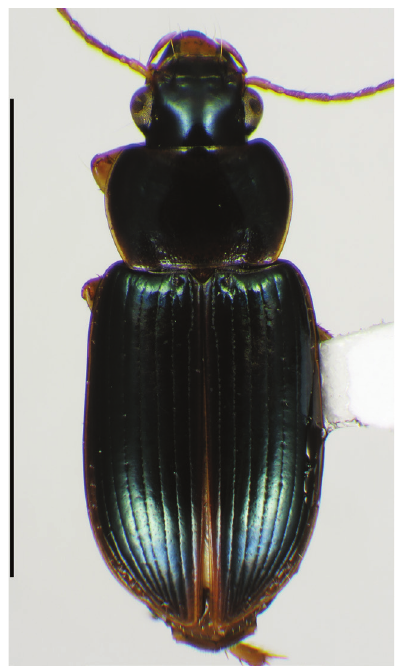
Figure 58. Habitus digital image of Selenophorus striatopunctatus species group, dorsal aspect, S. striatopunctatus Putzeys. Scale bar 5 mm.